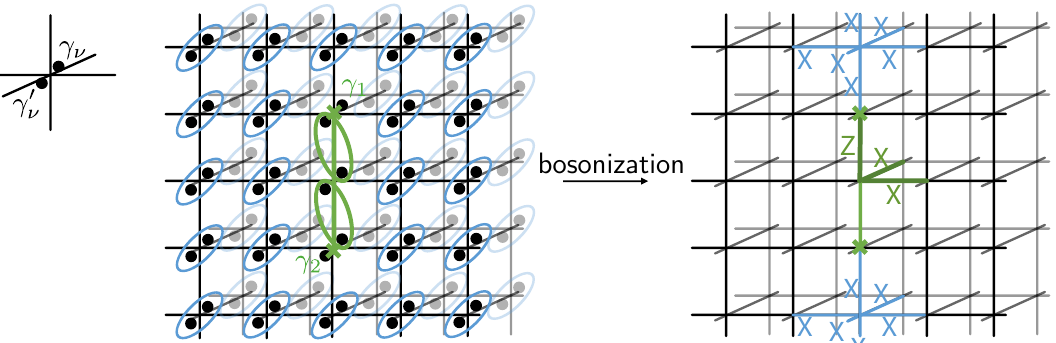
Figure 34: Left: The Kitaev chain is decorated on the open green line terminated at the two endpoints corresponding to the point defects (green crosses), which makes the Majorana fermion paired with the other one on its adjacent vertex; otherwise, Majorana fermions are paired within each vertex. Two unpaired Majorana fermion mode γ and γ are left on the two point defects respectively. Right: after bosoniza- 1 2 tion, the pairing term on the Kitaev chain becomes the hopping operator U open twist string, while the pairing term on each vertex not on the twist string be- comes the 6-body vertex X -stabilizers. Moreover, the 6-body vertex X -stabilizers are removed from the two vertices where the point defects (green crosses) are